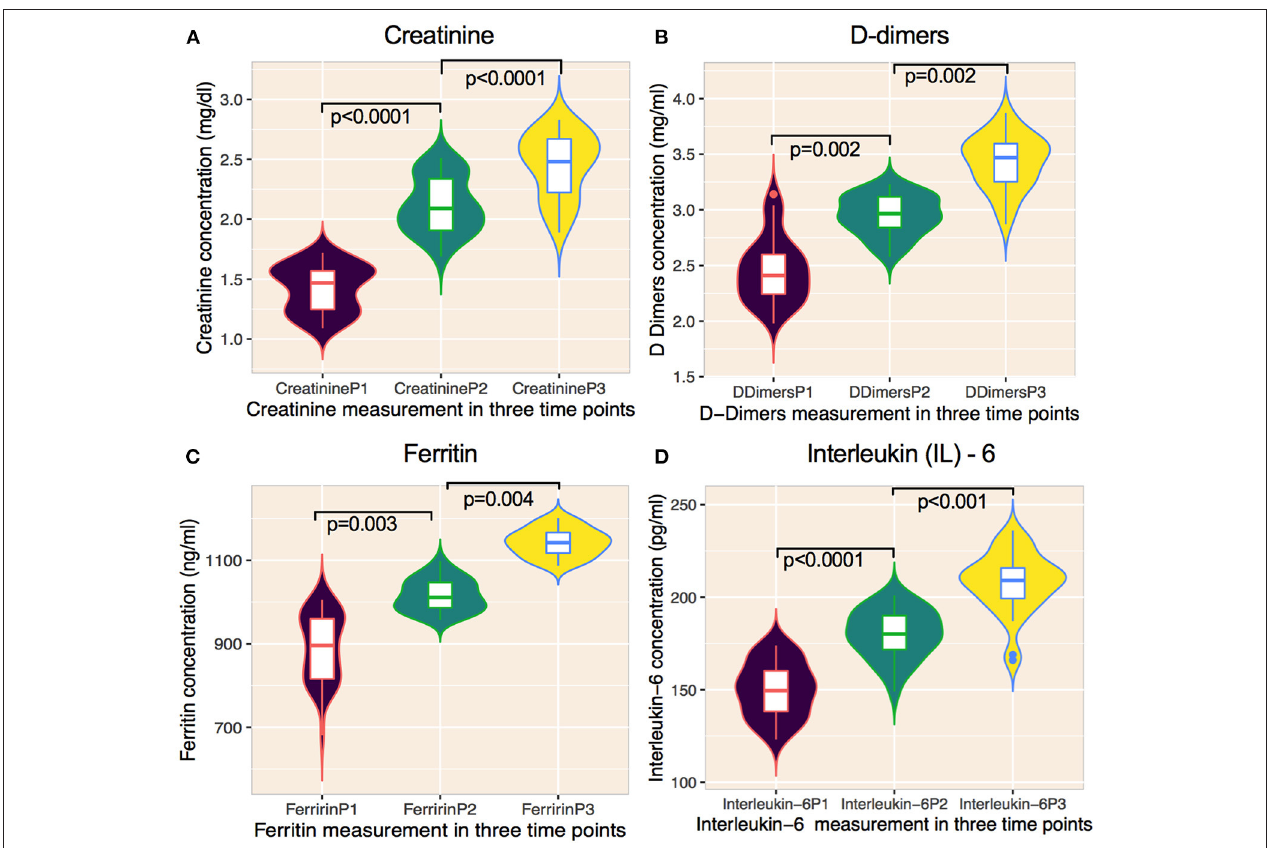
FIGURE 3 | Changes of laboratory features on cancer patients undergoing cytotoxic chemotherapy on prior COVID-19 infected patients. (A–D) Graphs showing the temporal changes in creatinine and inflammatory markers. (A) creatinine, (B) D-dimers, (C) ferritin, and (D) interleukin-6) of cancer patients infected with SARS-CoV-2 and subsequently treated with anti-cancer therapy. Data are median (IQR). Solid lines within violins represents median, 25% percentile, and 75% percentile. Violins show min-max ranges. The Mann-Whitney U test was used for calculating p values. P1, measurement before administering chemotherapy; P2, measurement after first chemotherapy cycle, P3, measurement 10 weeks after the end of